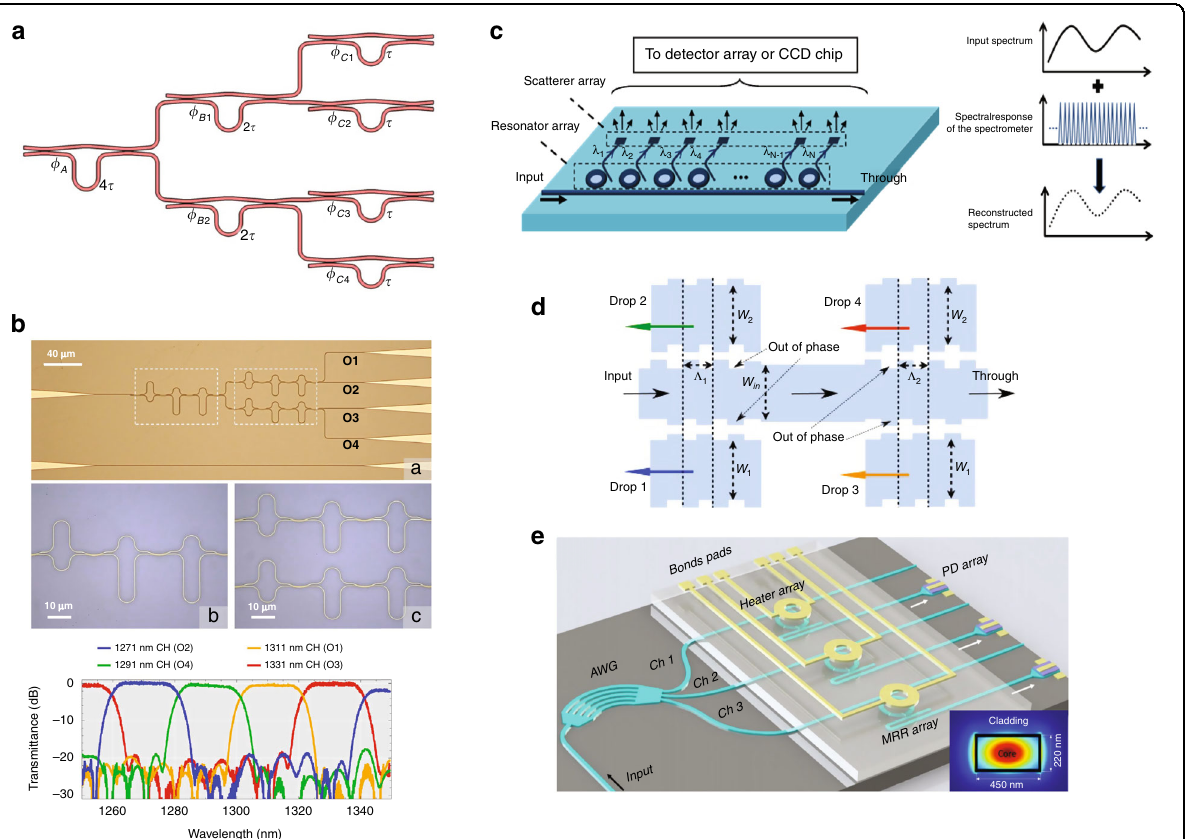
Fig. 9 Narrowband- fi lters based spectrometers on silicon photonics platform. a Schematic of a cascaded MZI fi lters based spectrometer 73 . b Spectrum tailoring of cascaded MZI fi lters based spectrometers by optimizing the couplers at each MZI 74 . c Schematic of a ring resonators array based spectrometer 79 . d Cascaded Bragg gratings based spectrometer 80 . e Spectrometer composed of both AWG and ring resonators 81 . a Reprinted from ref. 73 with permission from IEEE Publishing. b Reprinted from ref. 74 with permission from IEEE Publishing. c Reprinted from ref. 79 with permission from Optica Publishing Group. d Reprinted from ref. 80 with permission from Optica Publishing Group. e Reprinted from ref. 81 with permission from IEEE